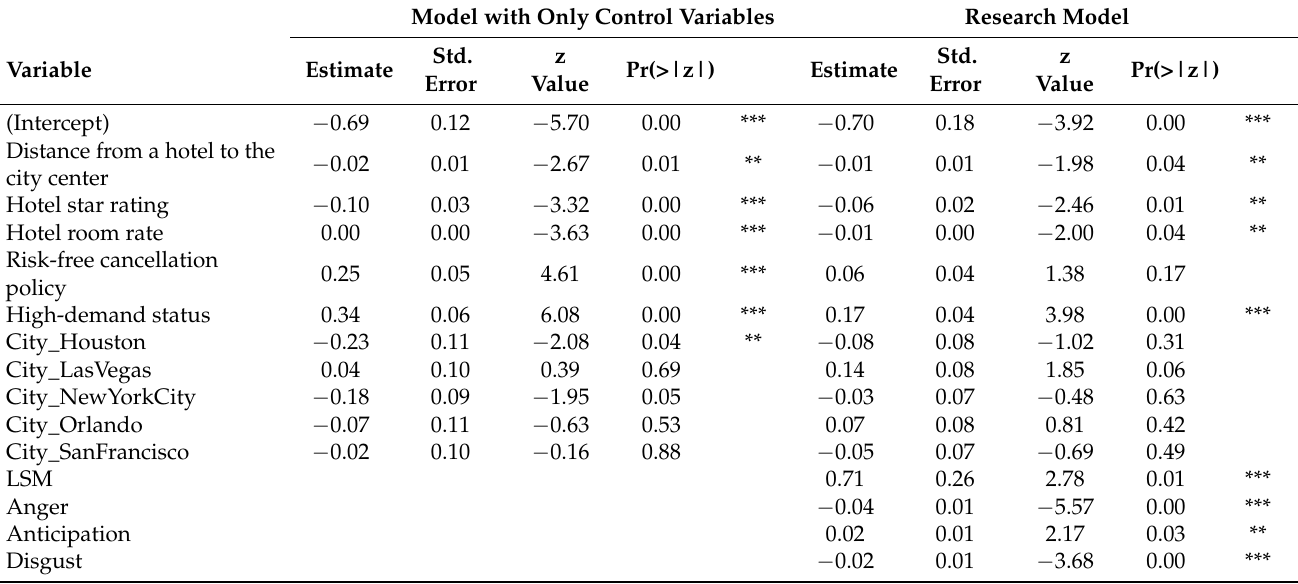
Table 4. Beta regression result and